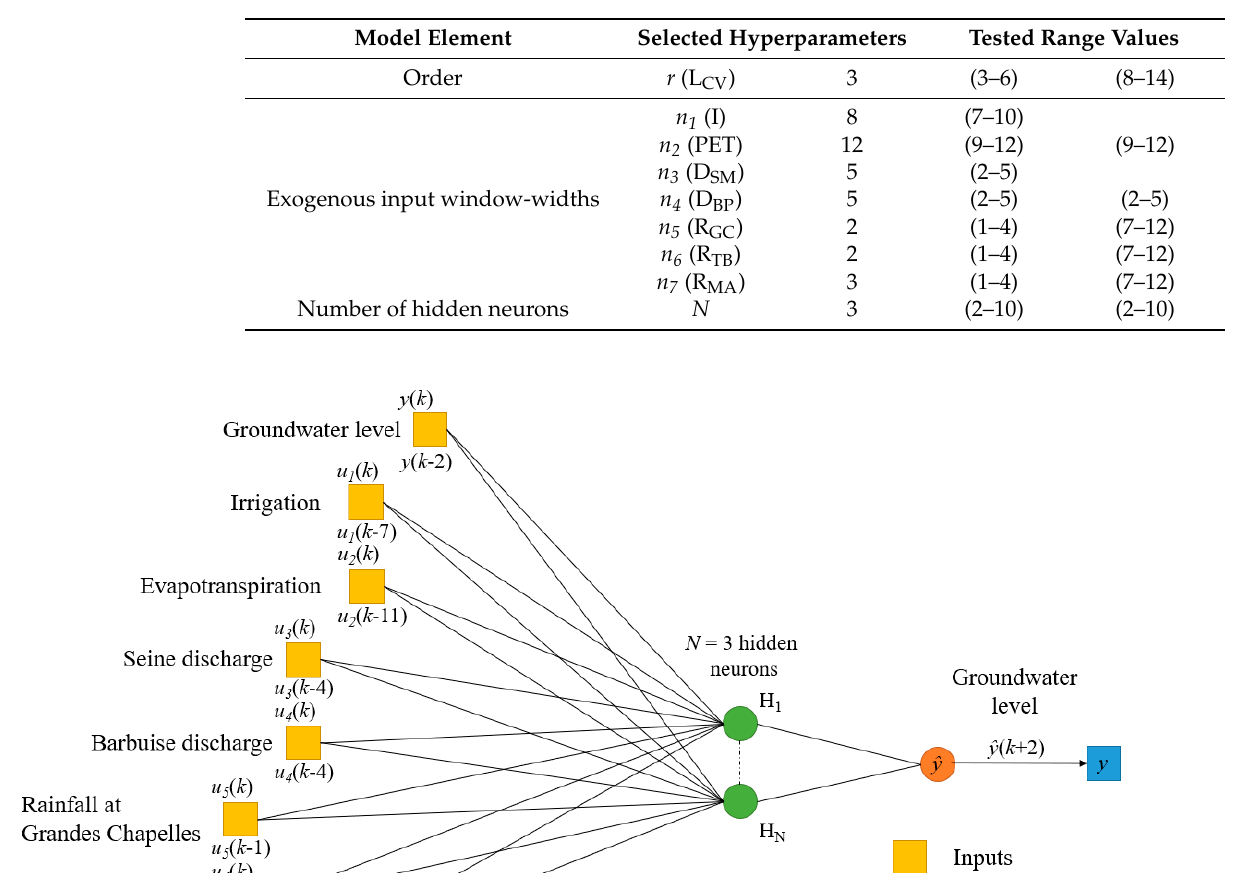
Table 5. Selected architecture using the design procedure synthetized in 2.1.5.